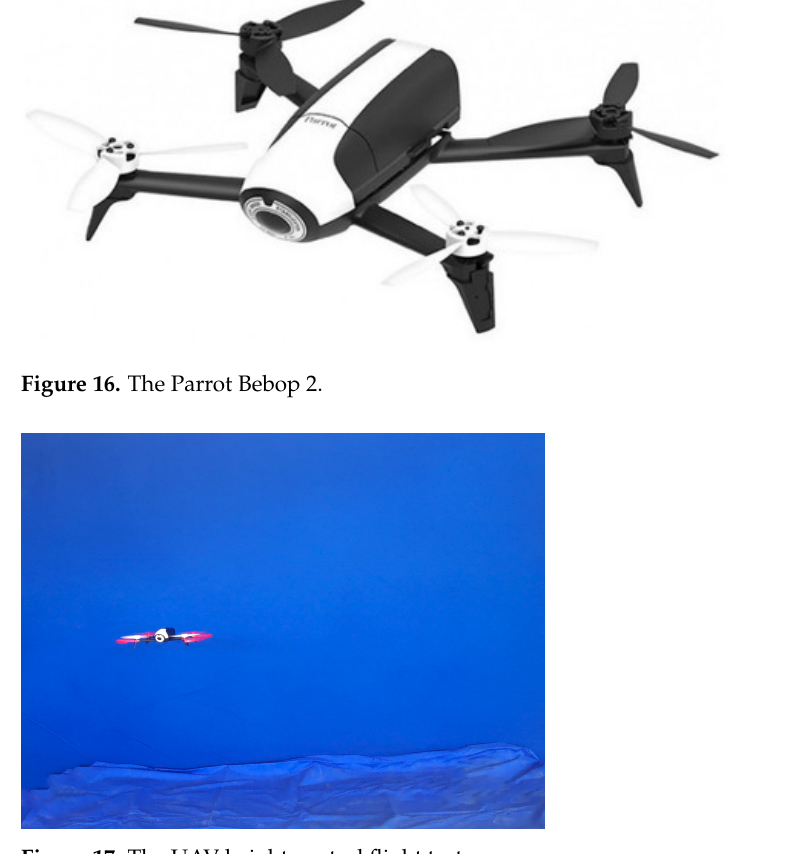
Figure 17. The UAV height control flight test.